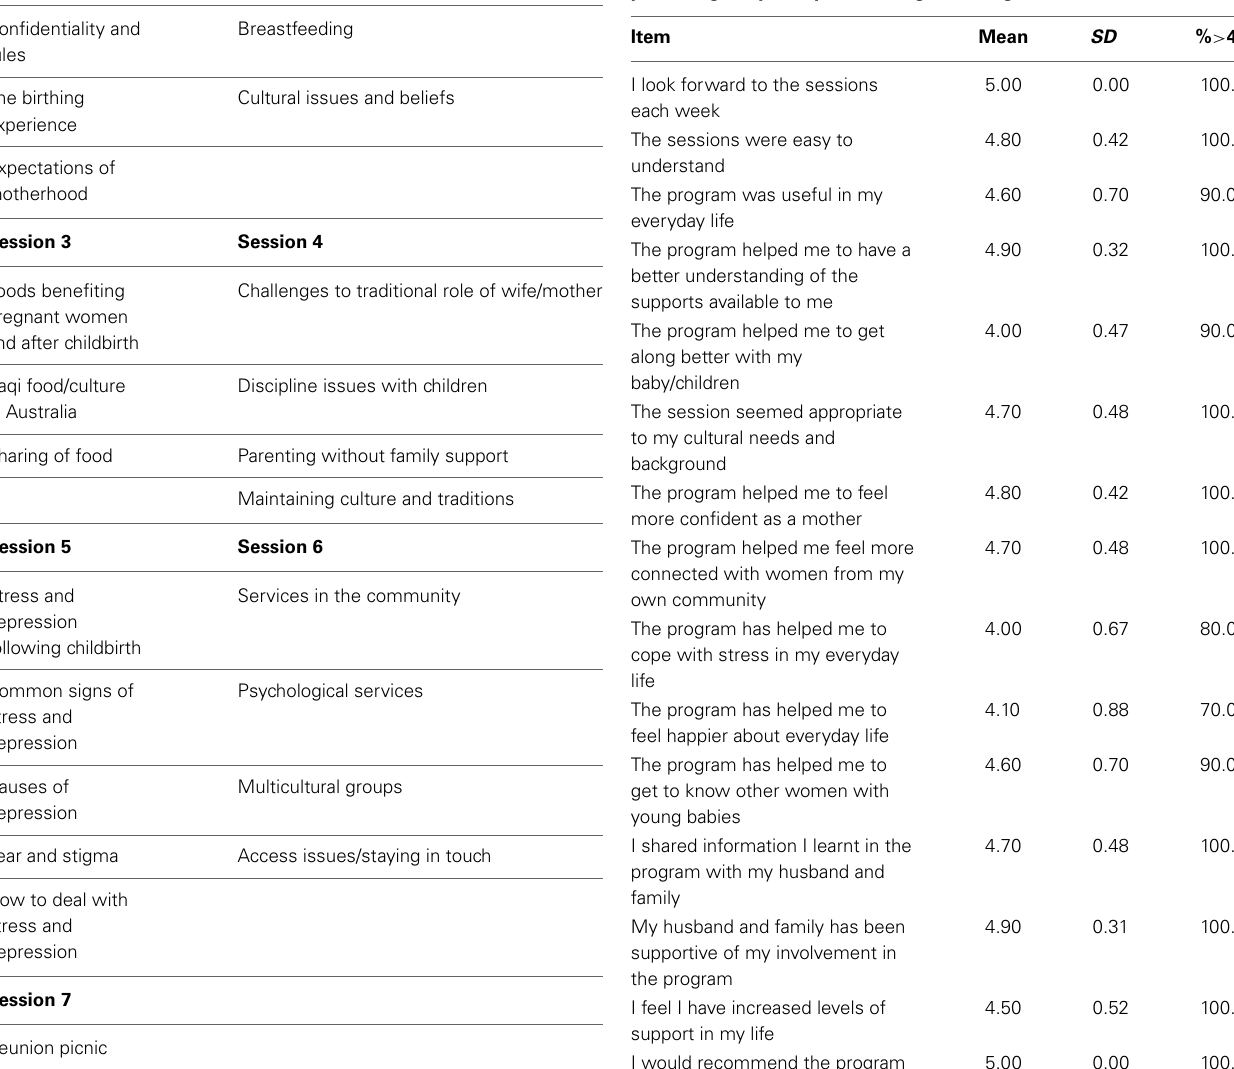
Table 2 | Session content of the Iraqi support group. Table 3 | Mean participant ratings of the enjoyment of the overall program (1, not at all enjoyable; 5, I enjoyed it very much), with the percentage of participants who gave ratings of 4 and